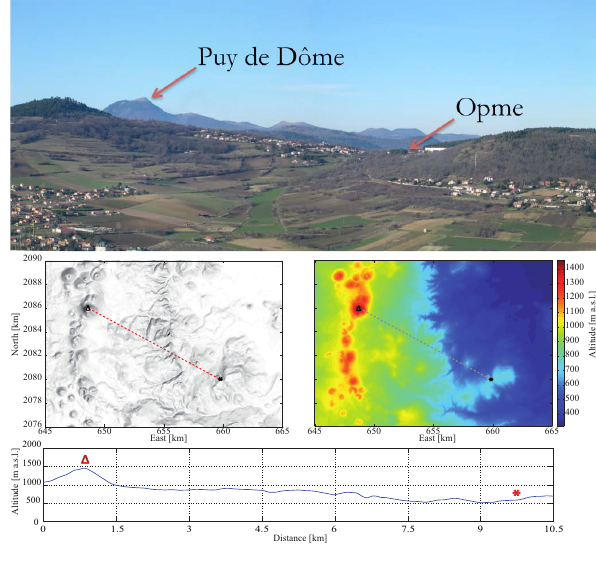
Fig. 1. Topographical view of the two measurement